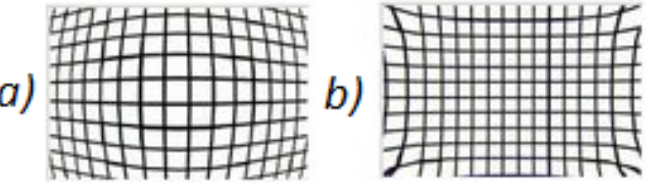
Figure 4. Image deformation caused by the camera lenses.